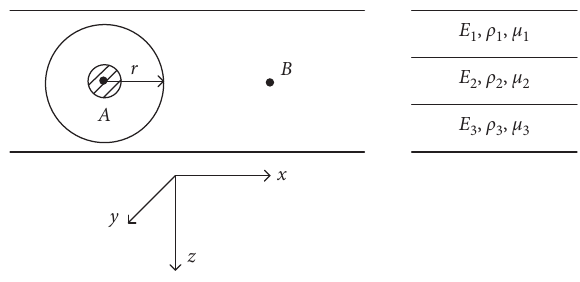
Figure 2: Coordinate system for